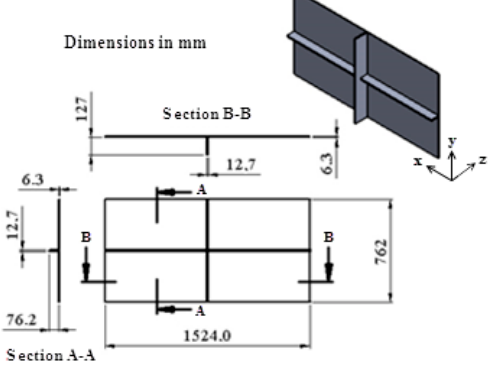
Figure 3. Stiffened plate used for computational model verification.